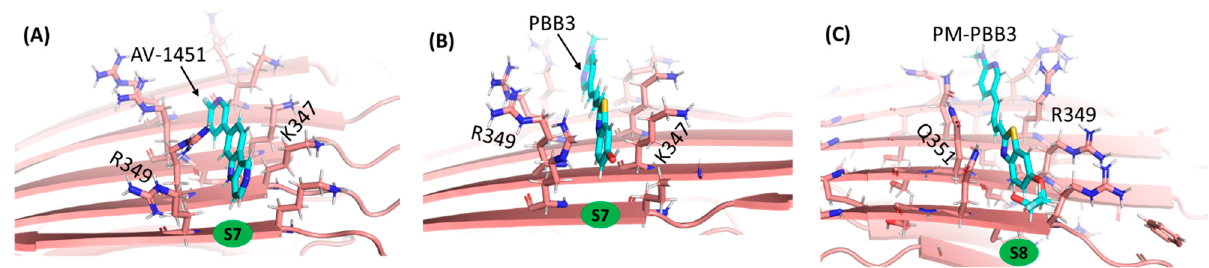
Figure 3. Molecular interactions of PET probes to Tau PiD taken after 100-ns MD simulation. ( A ) AV-1451 and ( B ) PBB3 binding to R349 and K347 sidechain hydrogens in site S7 and ( C ) PM-PBB3 binding to R349 and Q351 sidechain hydrogens in site S8.